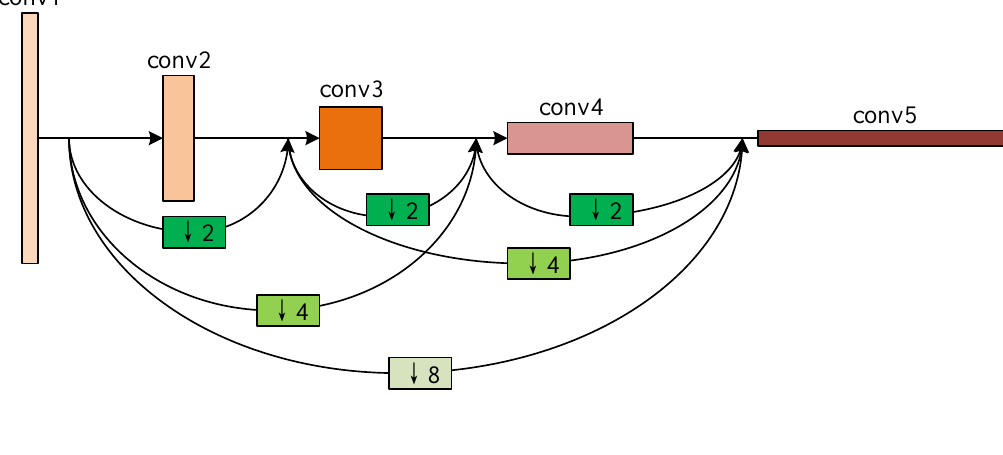
Figure 4. The dense connection of the 4 convolutional layers in the proposed lung parenchyma segmentation sub-network.